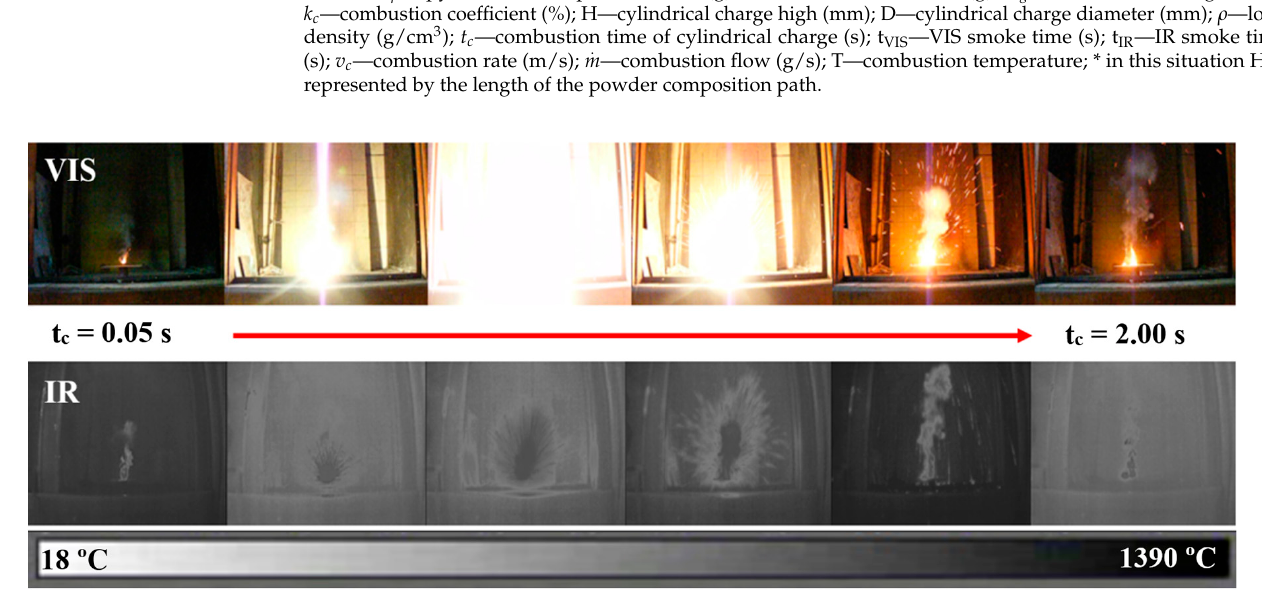
Figure 5. PC1 pyrotechnic tablets combustion in the first 2 s in VIS and IR mode.